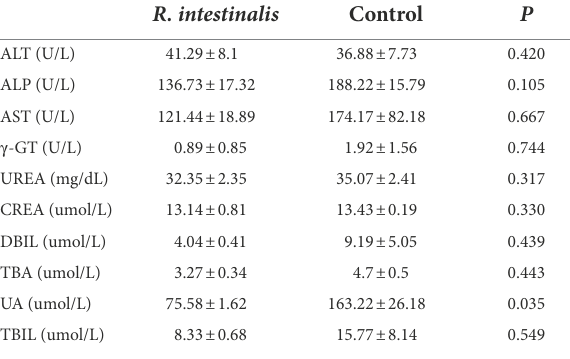
TABLE 4 Clinical chemistry results of acute toxicity study.